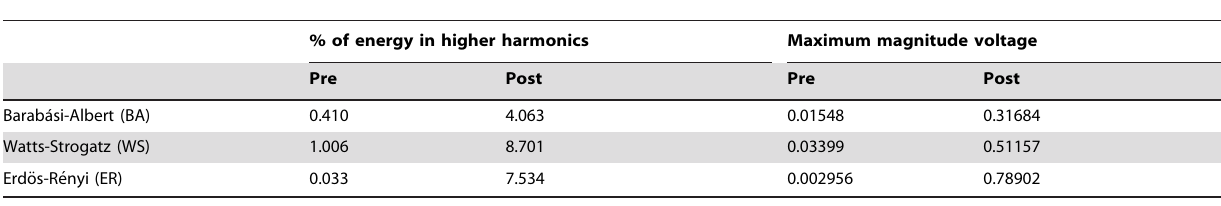
Table 1. Portion of results for graphs with N ~ 175 nodes. % of energy in higher harmonics